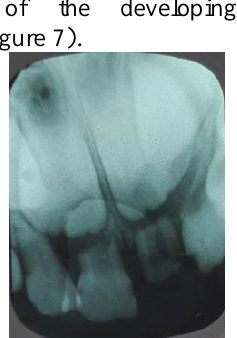
Figure 7: follow up x-ray showing normal resorption of the roots (note; the age of the child at this x-ray was 5 years and 2 months)